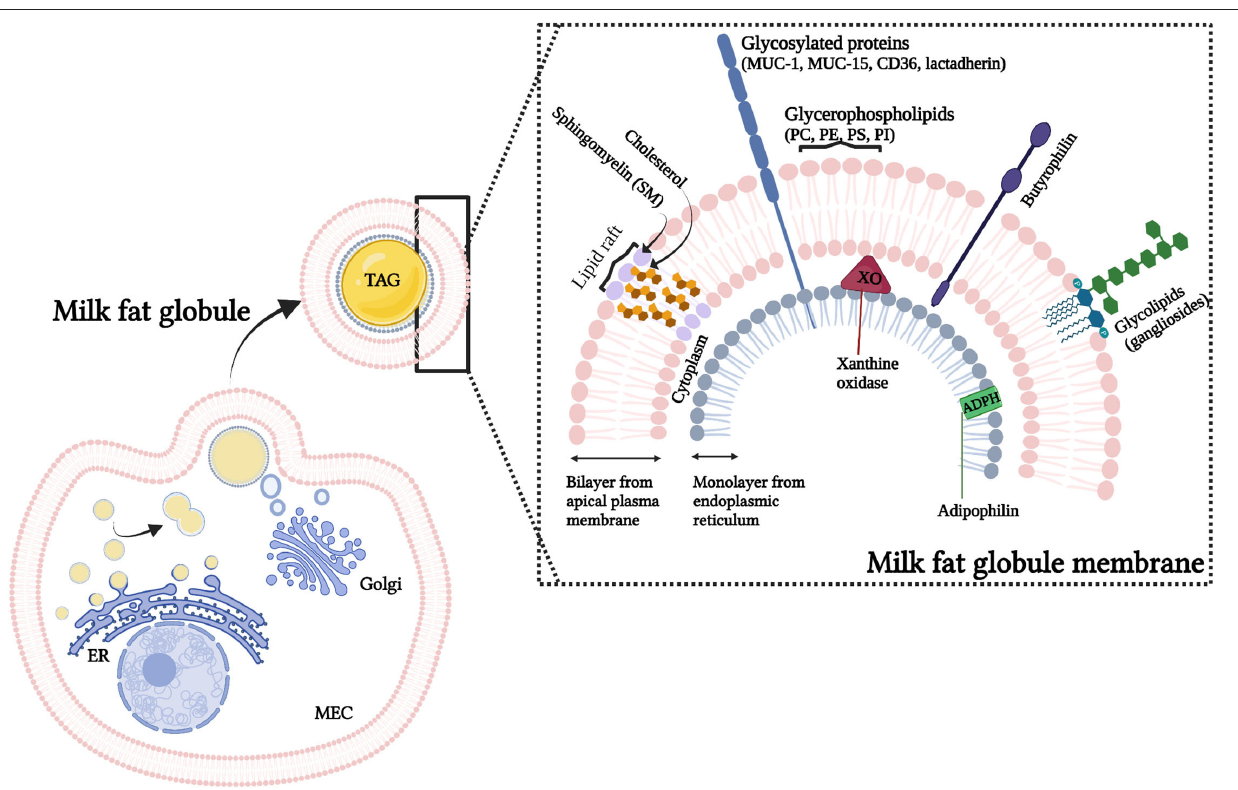
FIGURE 1 | Representation of the origin and structure of the milk fat globules (MFG). MFG are secreted from the mammary epithelium cell (MEC), with components from the endoplasmic reticulum (ER), cytoplasm and cellular membrane. The secreted MFG contain a triacylglycerol (TAG) core and a tri-layered structure, the milk fat globule membrane (MFGM). The MFGM, in detail, shows the lateral segregation of sphingomyelin and glycolipids surrounded by the glycerophospholipids. Illustrative pictures of some of the major MFGM proteins (which includes mucins (MUC-1, MUC15), lactadherin, adipophilin (ADPH), xanthine oxidase (XO) and butyrophilin) are also presented. PC, phosphatidylcholine; PE, phosphatidylethanolamine; PS, phosphatidylserine; PI, phosphatidylinositol.